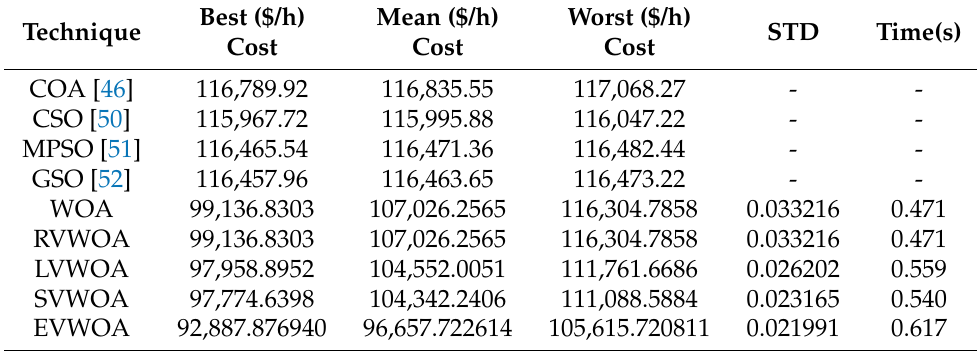
Table 13. Optimal schedule for the best cost obtained for Case study 5.